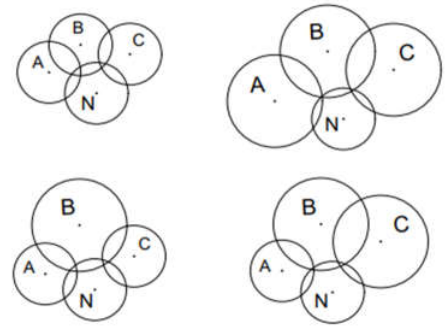
Figure 5. Multiple nodes intersect each other.